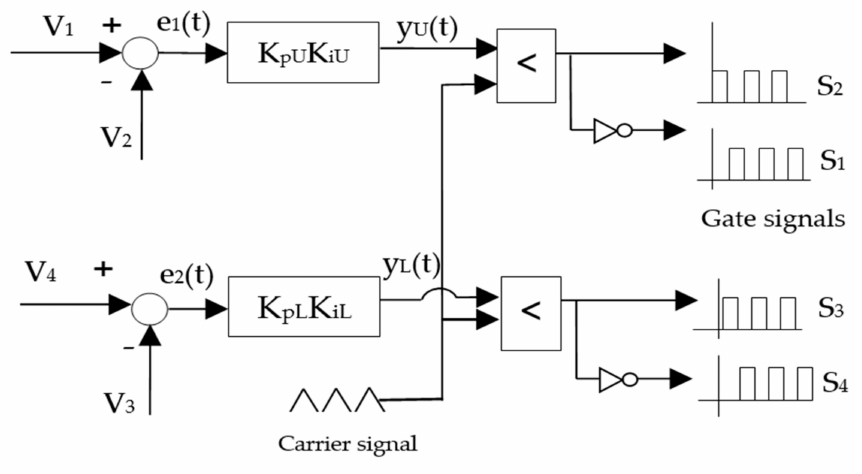
Figure 4. Block diagram of the PI